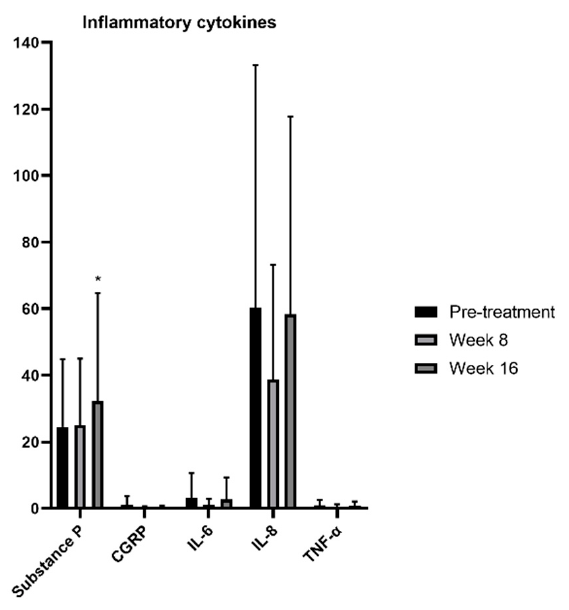
Figure 4. Changes of inflammatory cytokines before and after treatment of IPL combined with DCBE eye drops. * p < 0.05.